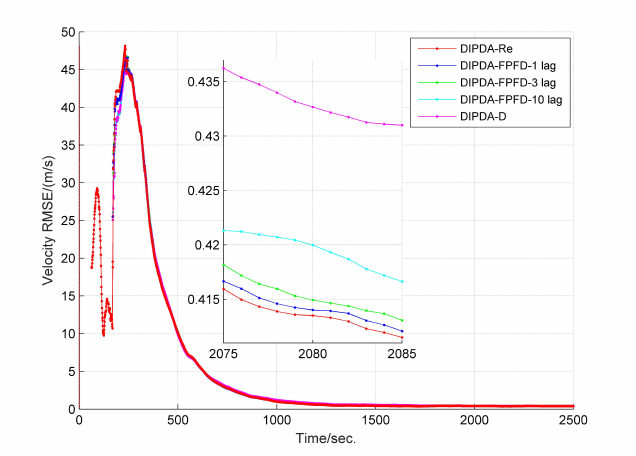
Figure 9. RMSE of estimated target velocity of DIPDA-D, DIPDA-Re, DIPDA-FPFD with different lags (case